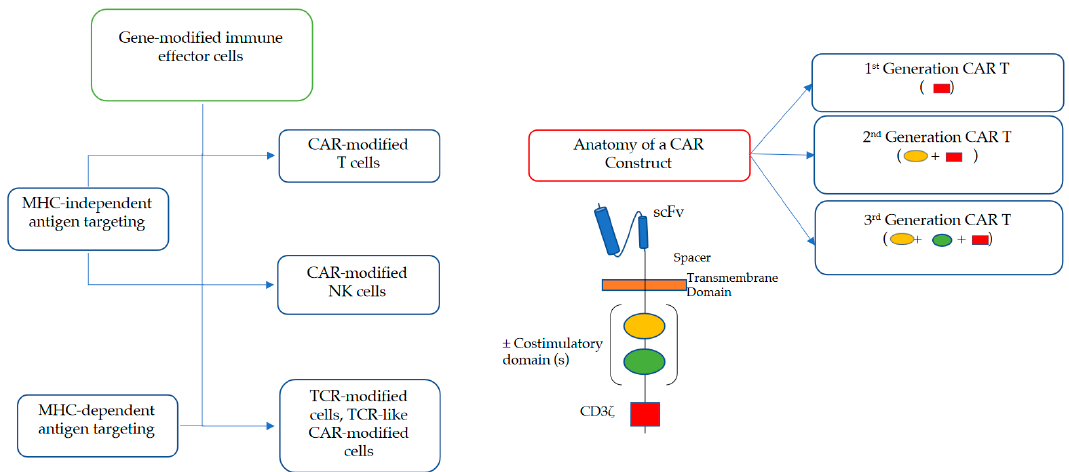
Figure 1. Types of gene-modified immune effector cell (IEC) constructs exerting cytotoxicity in a major histocompatibility complex (MHC)-independent or MHC-dependent manner as well as anatomy of chimeric antigen receptor (CAR) constructs.